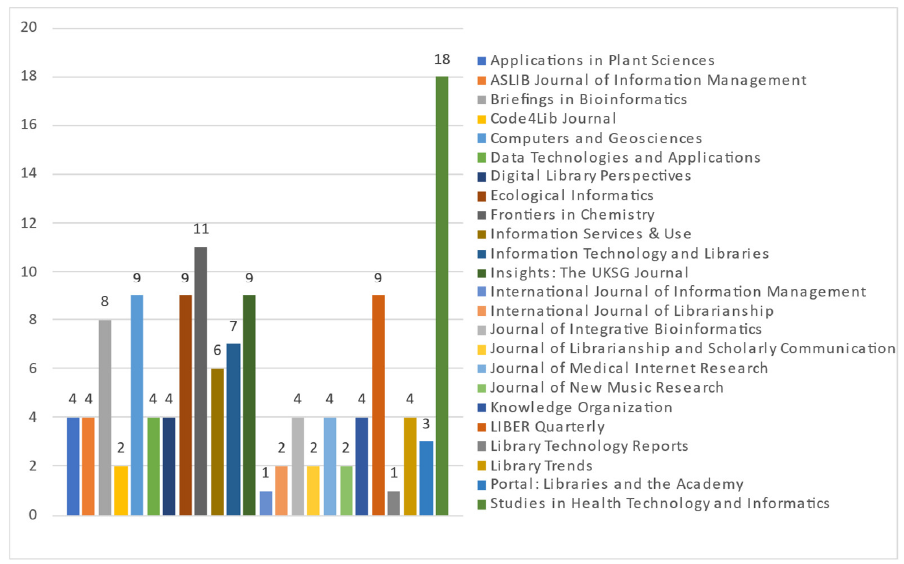
Figure 8. Number of Authors per Journal.